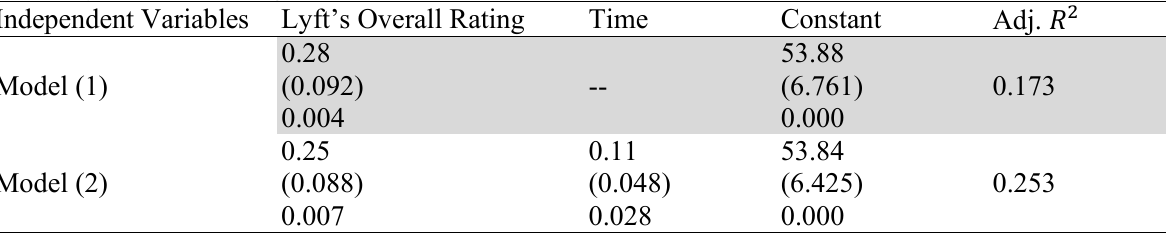
Summary of the OLS